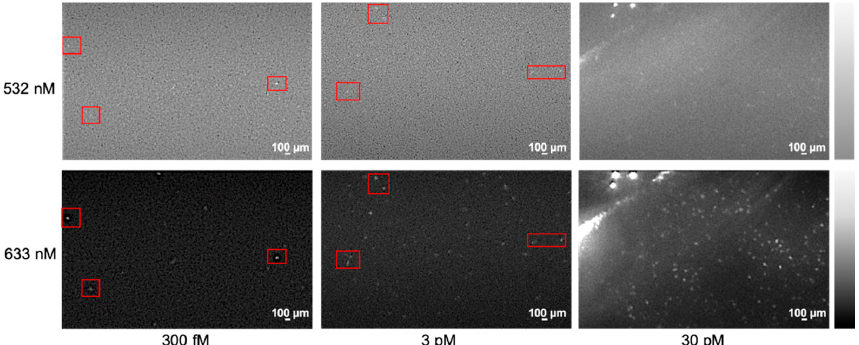
Figure 3. A string-like fluorescent barcode dye-labeled RNA target with various concentrations (300 fM–30 pM) imaged by a Total Internal Reflection Fluorescence (TIRF) microscope with dual channel excitation (532 nm and 633 nm). The red boxes show the molecules being observed unber both excitations.